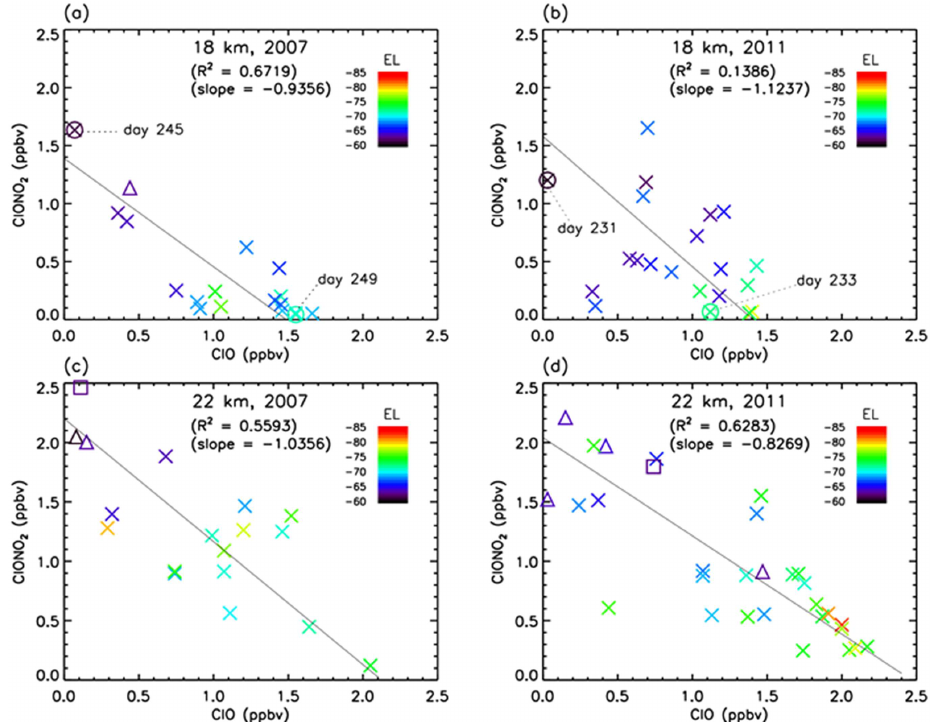
Figure 10. Scatter plot between ClO (Aura MLS) and ClONO 2 (Envisat MIPAS) mixing ratios between 8 August and 17 September (day 220–260) at 18 and 22km in 2007 and 2011. Crosses, triangles, and squares represent the data when Syowa Station was located inside the polar vortex, in the boundary region of the polar vortex, and outside the polar vortex, respectively. Solid lines are regression lines obtained by reduced major axis (RMA) regression. Color represents the equivalent latitude over Syowa Station on that day. Circles with crosses represent the days which are shown in Figs. 13 and